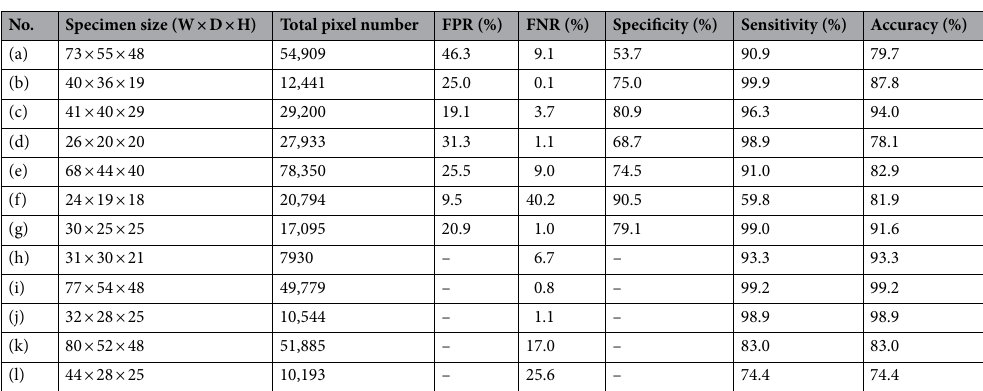
Table 1. Prediction results of NIR-HSI analysis for the submucosal GIST region. NIR near-infrared, HSI hyperspectral imaging, GIST gastrointestinal tumor, W width, D diameter, H height, FPR false-positive rate, FNR false-negative